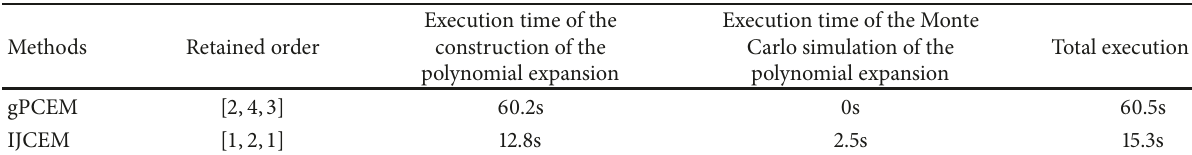
Table 4: Execution time comparison.